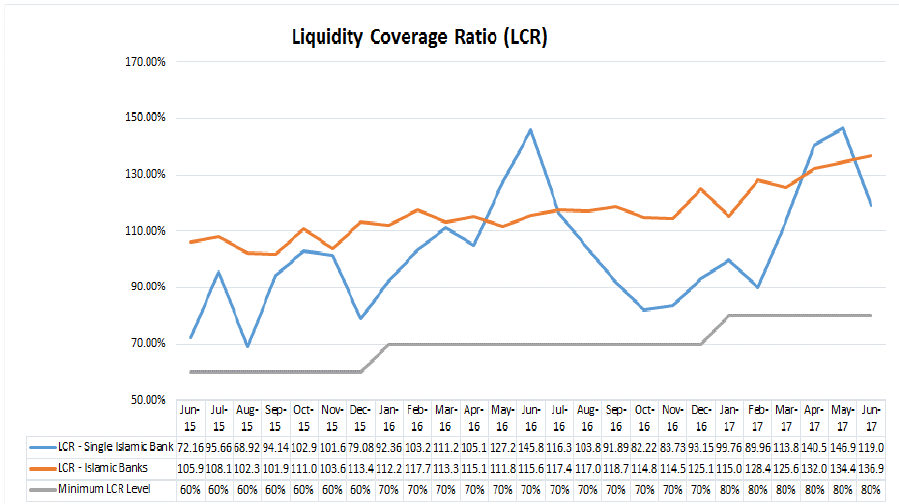
Figure 5. Graphical presentation of liquidity coverage ratio (LCR) between June 2015 and June 2017. Source: From author observation and Locally Incorporated Foreign Islamic Bank.